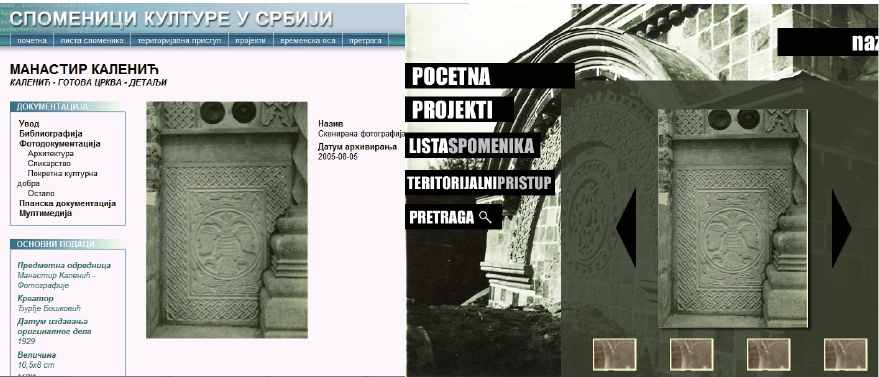
Fig. 3. Current graphical design of a digital repository ‘’Cultural Monuments of Serbia’’, on the left, and the suggestion of students, on the right. Source: Own photo (Mathematical Institute SASA,